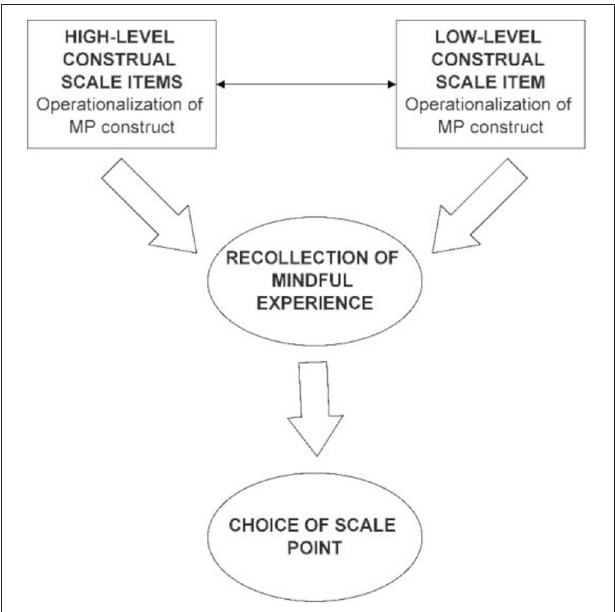
FIGURE 1 | Hypothesized effect of construal level on the recollection of mindful